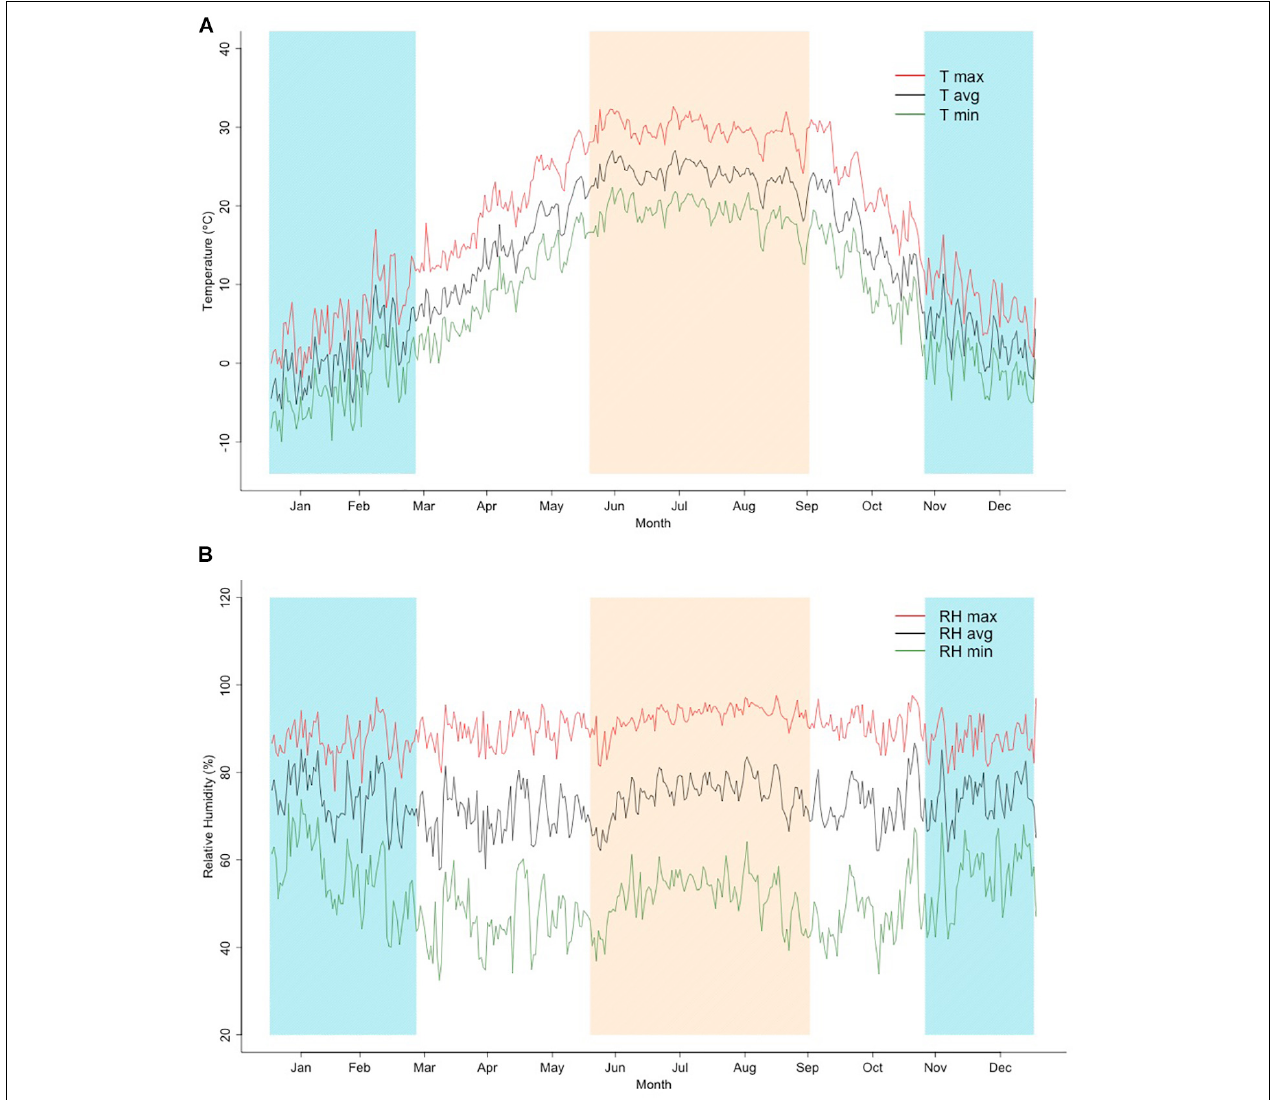
FIGURE 1 | (A,B) . Average values of daily maximum (T max), average (T avg), and minimum (T min) temperatures, and daily maximum (RH max), average (RH avg), and minimum (RH min) relative humidity through the year for years 2015–2019 as used in this study. Shadowed regions represent hot (top-left to bottom-right lines) and cold (bottom-left to top-right lines)